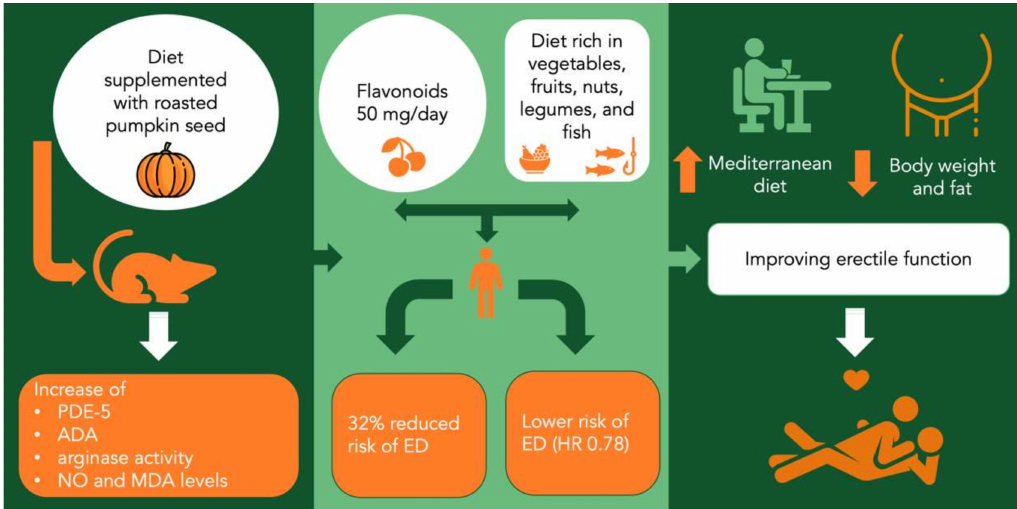
Figure 2. Relationship between dietary patterns and erectile dysfunction. Relationship between dietary patterns and erectile dysfunction. PDE5 = phosphodiesterase-5 inhibitors; ADA = adenosine deaminase; NO = nitrogen oxide; MDA = Malondialdehyde; ED = erectile